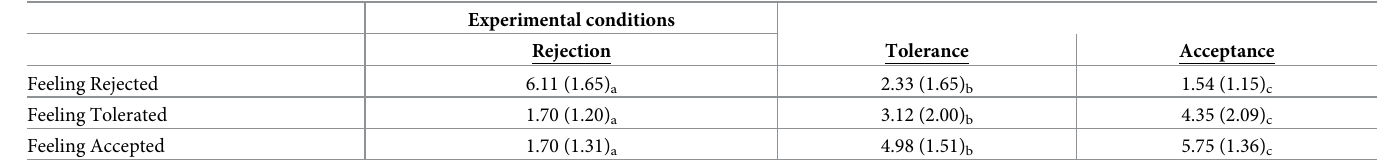
Table 3. Results of the manipulation check items for Study